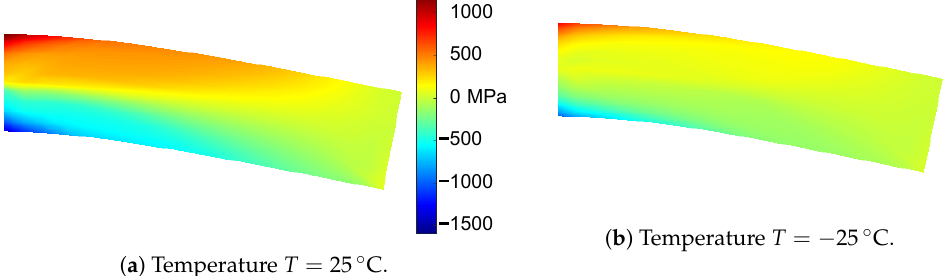
Figure 6. Deformed configuration with a contour plot of the normal stress component parallel to the x axis (within the reference configuration). The color bar applies to both plots (Example